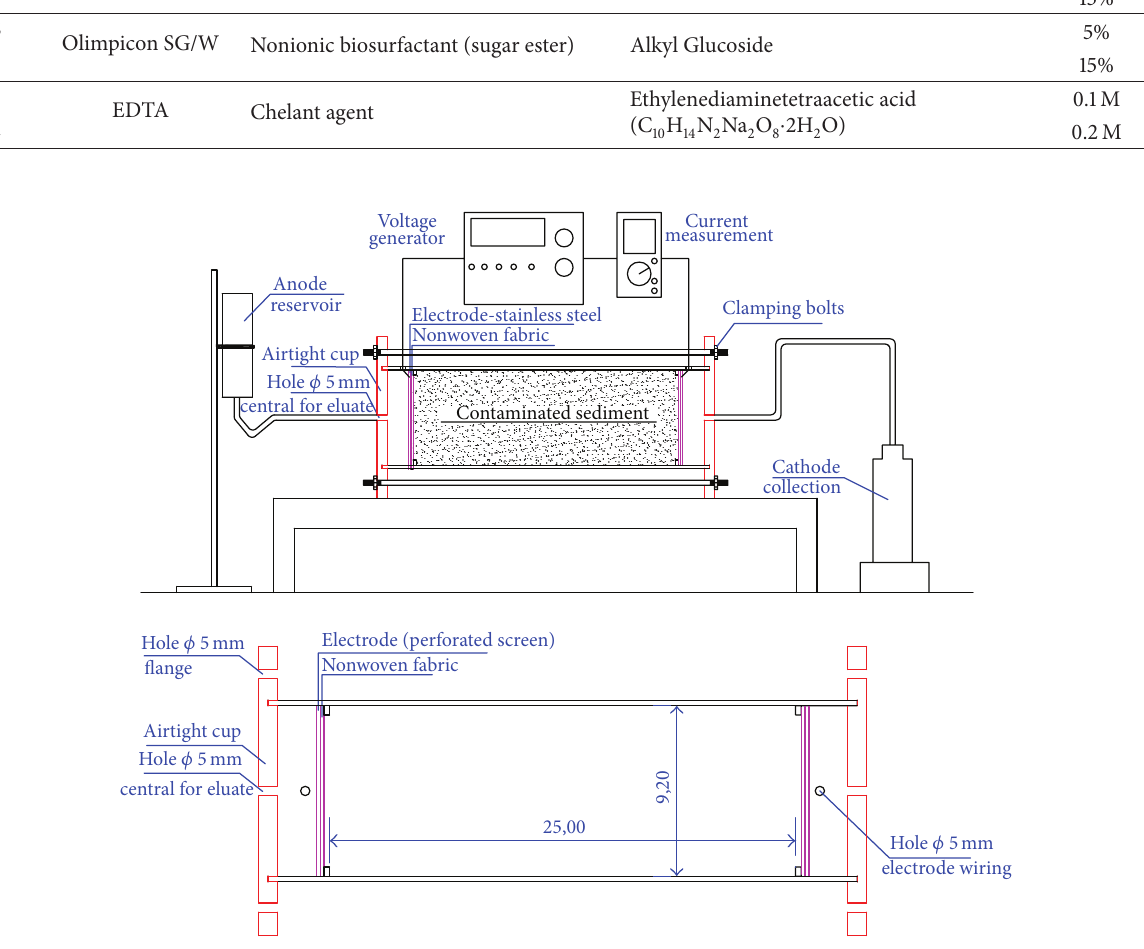
Figure 2: Schematic of the experimental